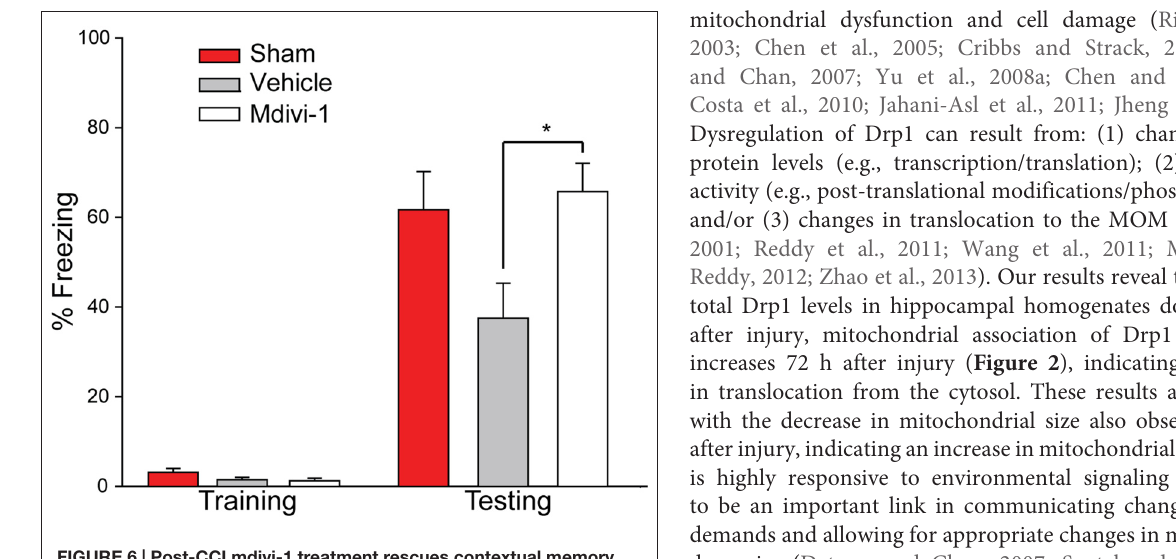
FIGURE 6 | Post-CCI mdivi-1 treatment rescues contextual memory after CCI injury. CCI animals were treated with either 3.0 mg/kg of Mdivi-1 ( n = 8) or vehicle ( n = 6) starting 30 min post-injury, and subsequently at 24 and 48 h post-injury. Four weeks post-injury, rats were exposed to the FC training chamber, before receiving a mild foot shock (2 s, 7.0 mV). Prior to foot shock, animal in all three groups explored the context equally (training). Twenty-four hours later (one-trial) the rats were replaced back into the training chamber and their freezing behavior was recorded for a total of 3 min. Rats treated with Mdivi-1 demonstrated improved contextual fear memory in a one-trial context-specific FC task indicated by a significant increase in freezing behavior compared to vehicle-treated controls. Data are presented as the mean ± SEM. ∗ p <